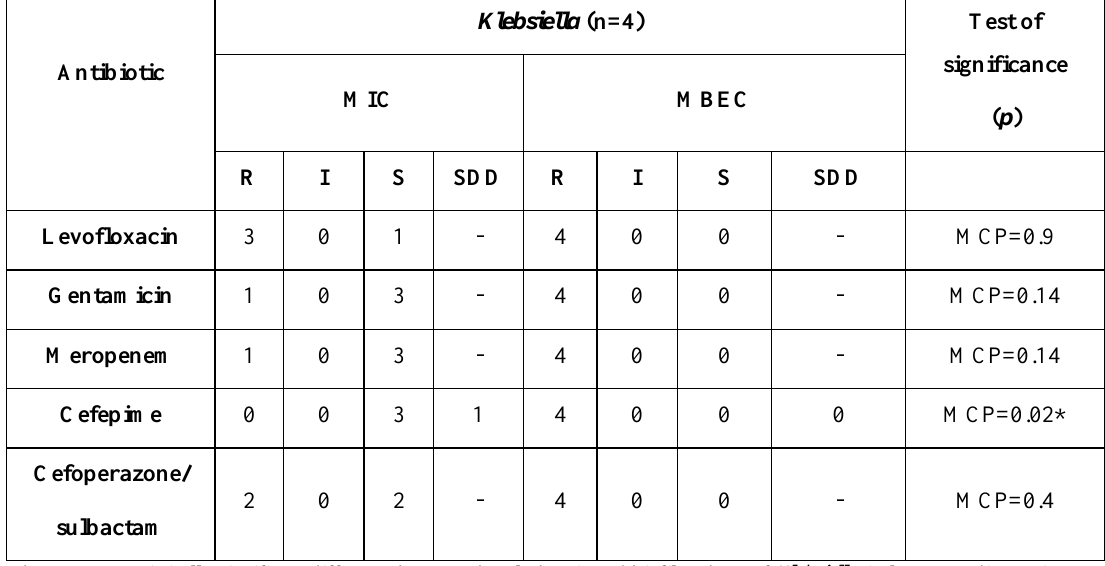
Table 3. Interpretation of MIC and MBEC results for Klebsiella biofilm forming